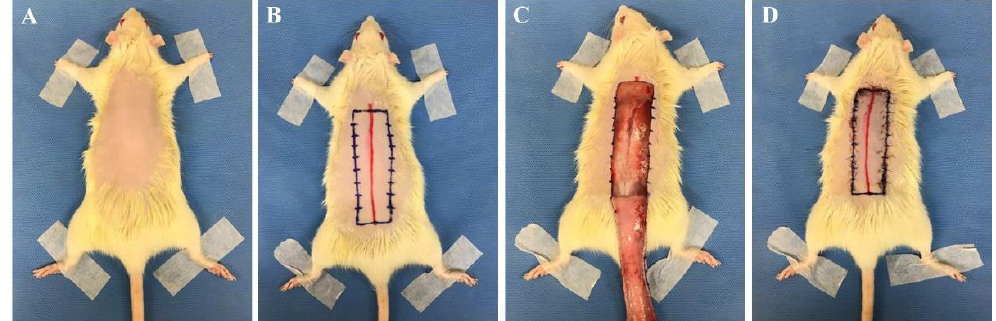
Figure 1. Skin flap procedure in rats. ( A ) Hair from the dorsal side of the rat was removed. ( B ) A 9 cm long red line originating at the level of the base of the scapulae was drawn on the dorsal midline. A rectangular area was drawn with its long edges parallel to and 1.5 cm away from the midline. ( C ) The skin was incised along the cranial and lateral lines of the rectangular area. ( D ) The skin flap was immediately re-attached in its original position and sutured with 4-0 nylon single stitches at 0.5 cm intervals. All experimental procedures were approved by the Institutional Animal Care and